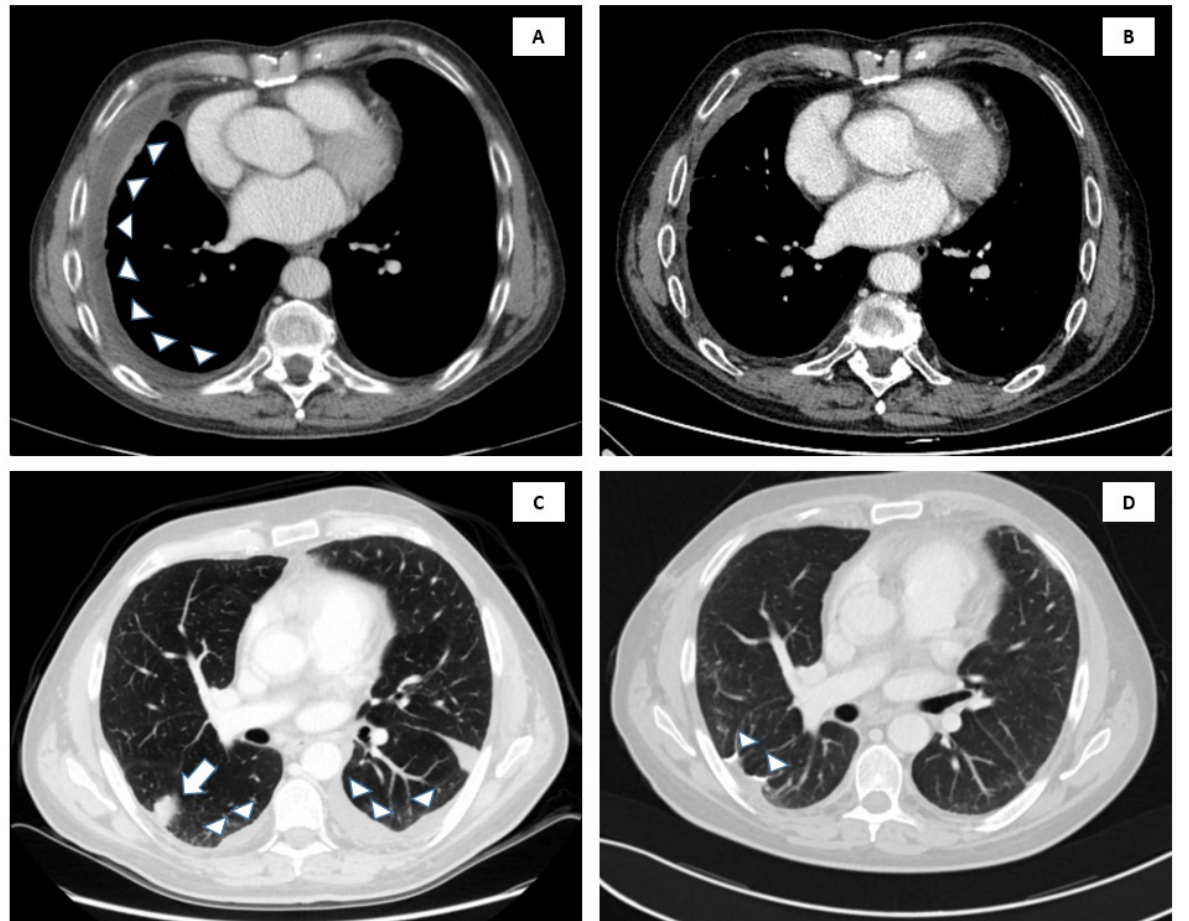
Figure 2. CT scans of the two cases at onset of large B cell effusion-based lymphoma (EBL) and at the last evaluation. In case 1 at onset ( A ), but after drainage procedure of pleural effusion, the right pleura is thickened with minimal pleural effusion (arrowheads). At the last evaluation ( B ), the right pleural thickening and pleural effusion are markedly reduced. In case 2, onset scans ( C ) show bilateral pleural effusion (arrowheads), at the right upper lobe nodule (arrow). At evaluation post-intervention ( D ), note the subpleural suture in the site of wedge resection (arrowheads), and the absence of pleural effusion.